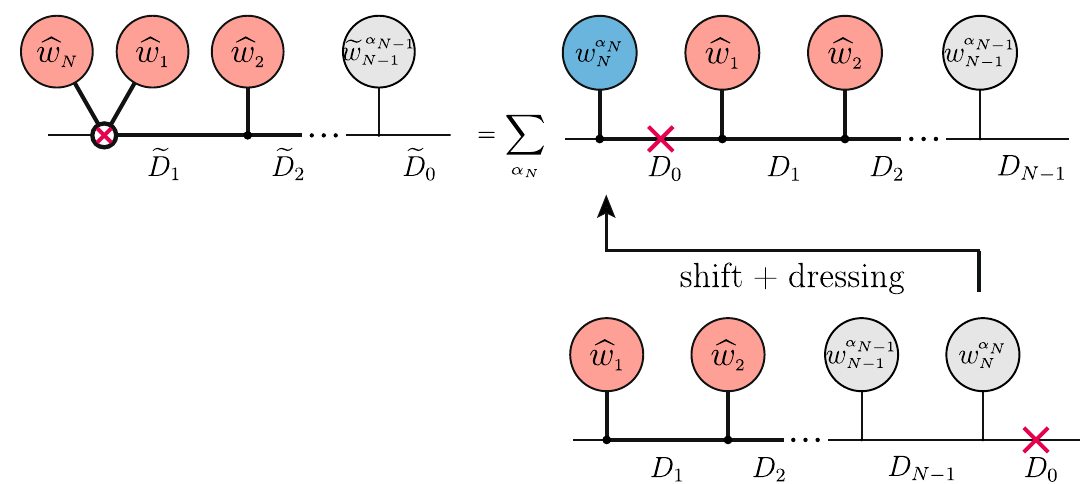
Fig. 10 Required dressing, loop-momentum shift and relabeling operations (94)–(96) before merging an open loop with a pinched ¯ D 0 propagator